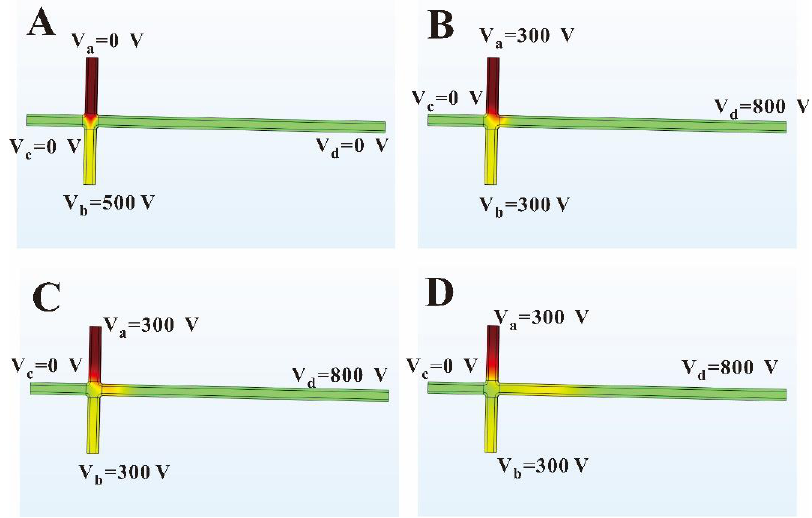
Figure 2. ( A ): the stage of sample injection; ( B – D ): the flow state of the sample in the stage of sepa- ration.